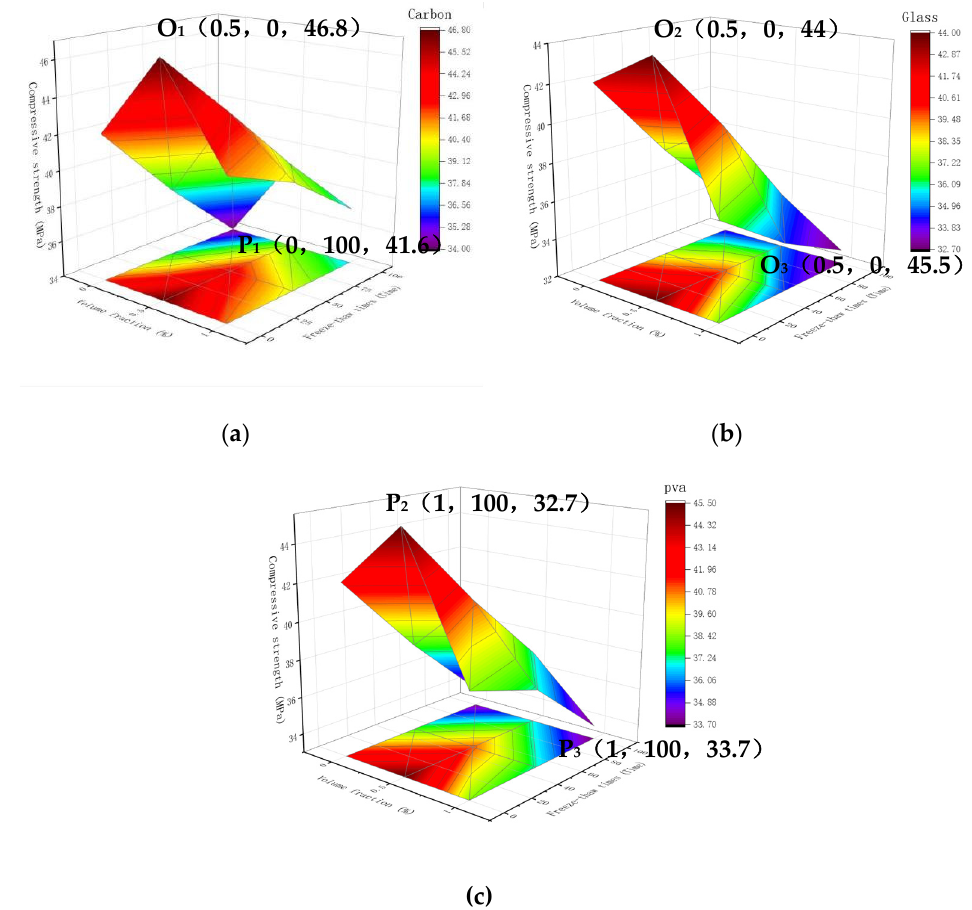
Figure 10. 3D surface map with projection: ( a ) Carbon fiber compressive resistance; ( b ) Compression resistance of glass fiber; ( c ) PVA fiber compression resistance.